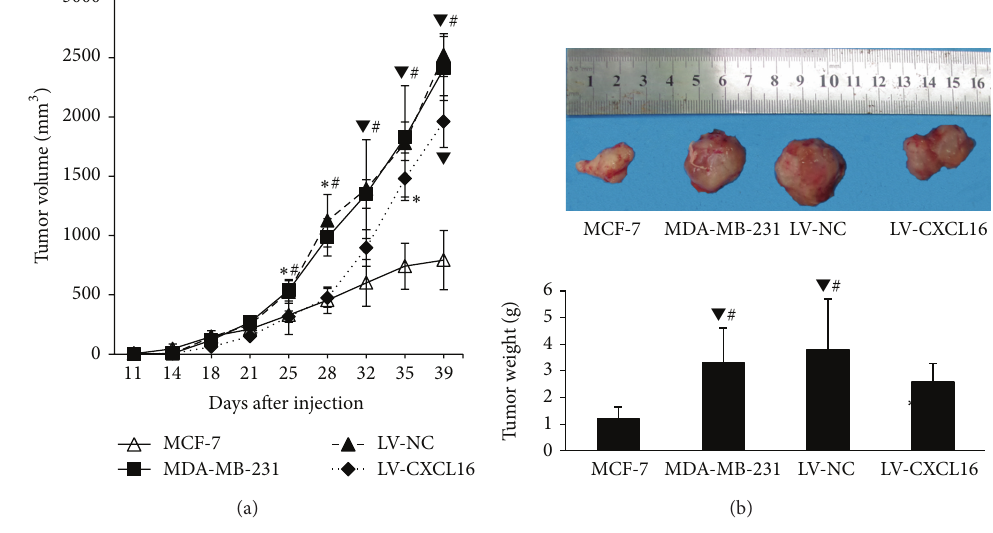
Figure 4: CXCL16 expression inhibited tumor development in vivo . Four groups of single cells (MDA-MB-231, LV-NC, LV-CXCL16, and MCF-7) were injected subcutaneously into mice and tumor growth was monitored. (a) CXCL16 overexpression led to a decrease in tumorigenesis. ∗ 𝑃 < 0.05 compared with MCF-7. # 𝑃 < 0.05 compared with MDA-MB-231. 󳶃 𝑃 < 0.01 compared with MCF-7. (b) CXCL16 overexpression reduced tumor volume and weight. # 𝑃 < 0.05 compared with MDA-MB-231. 󳶃 𝑃 < 0.01 compared with MCF-7. ∗ 𝑃 < 0.05 compared with